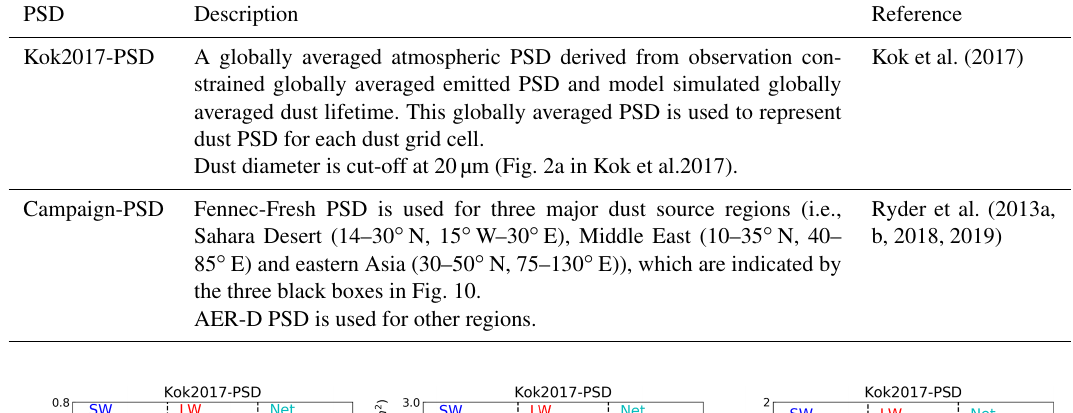
Table 5. The two observation-based dust PSDs used in DRE calculations (see Fig. 7). PSD A globally averaged atmospheric PSD derived from observation con- strained globally averaged emitted PSD and model simulated globally averaged dust lifetime. This globally averaged PSD is used to represent dust PSD for each dust grid cell.